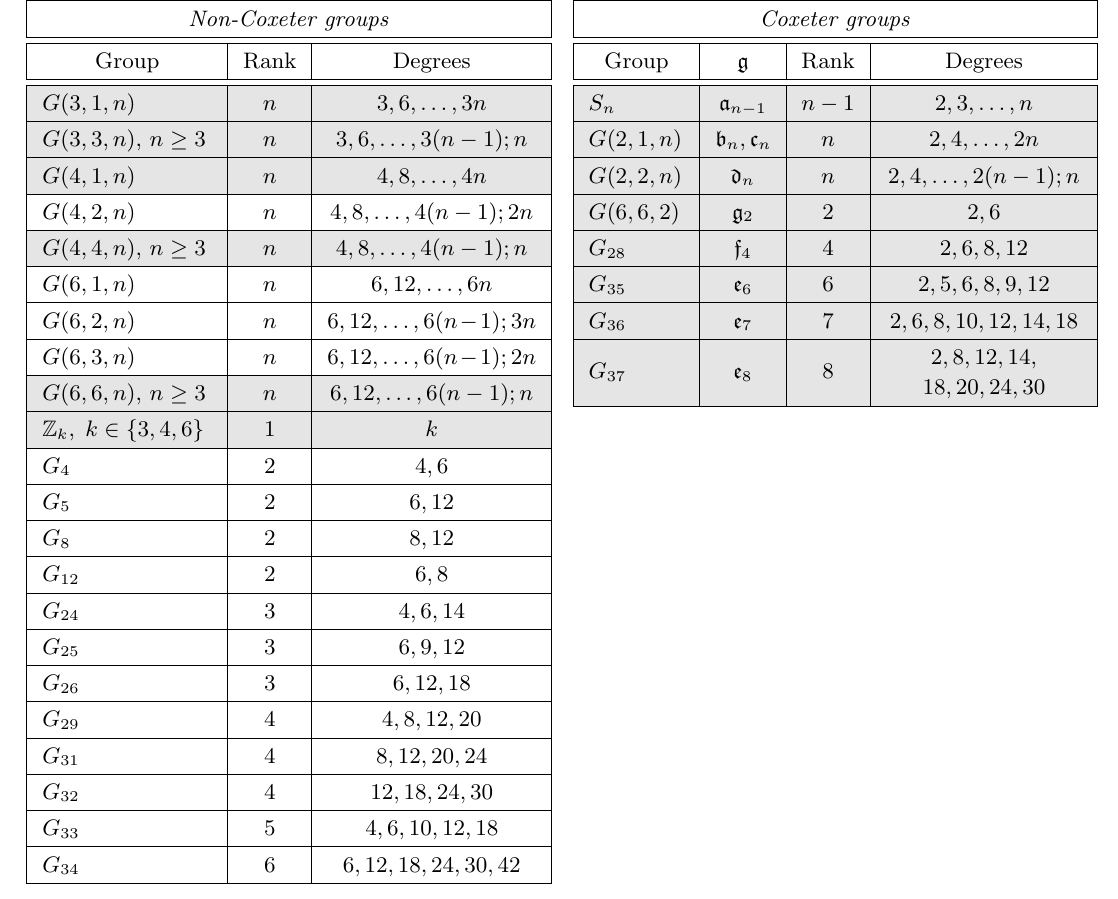
Table 1 . Irreducible crystallographic complex re(cid:13)ection groups, partitioned into non-Coxeter and Coxeter groups. For each group, we give the rank and the degrees of the fundamental